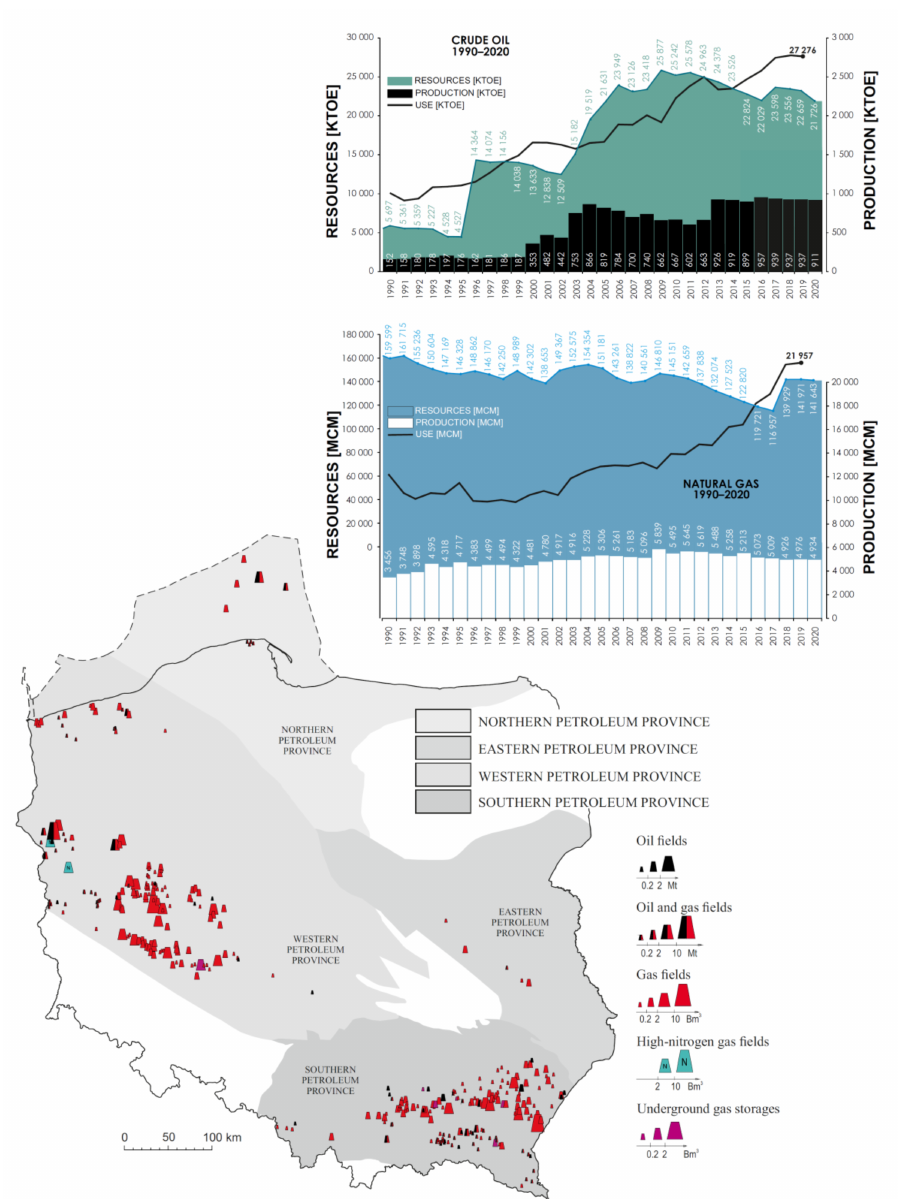
Figure 1. Crude oil and natural gas resources, production, and use in Poland 1990–2020 according to the Balances of mineral resources deposits in Poland [1,2]; location of oil and gas fields and underground gas storages in Poland in relation to petroleum provinces ([4]; compare to